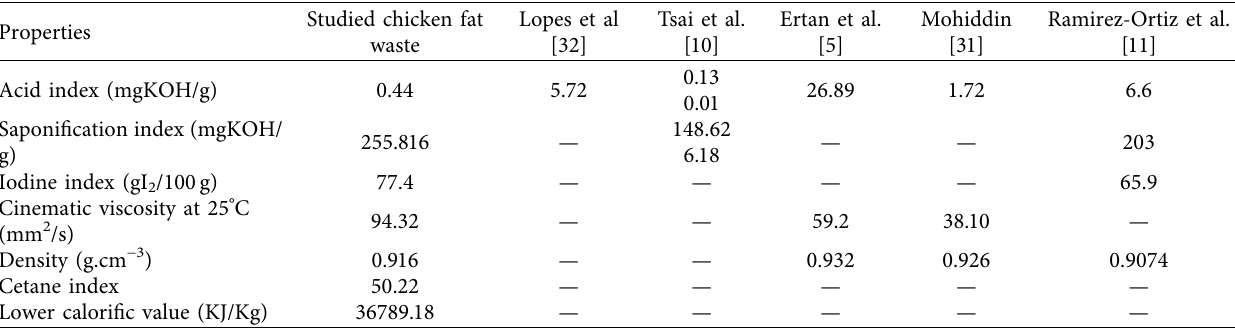
Table 2: Comparison of experimental results with those obtained by other